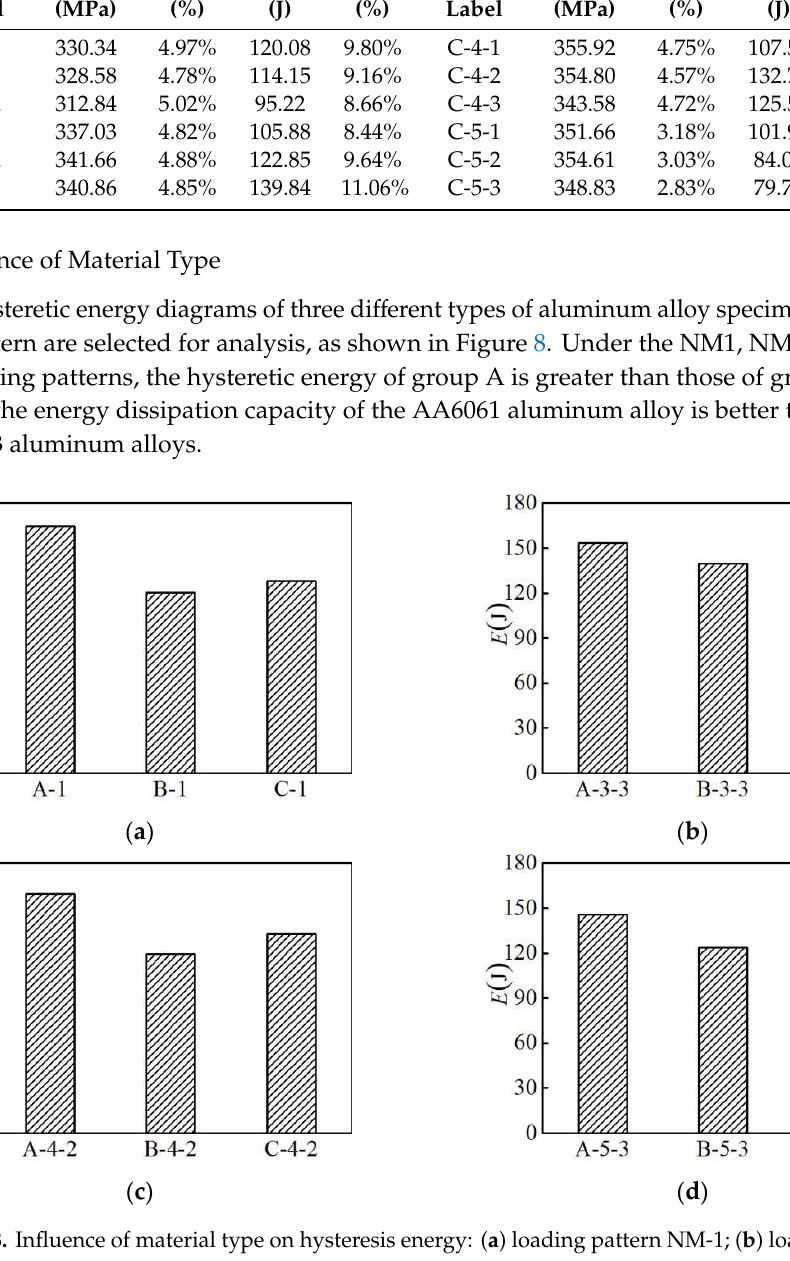
Figure 8. Influence of material type on hysteresis energy: ( a ) loading pattern NM-1; ( b ) loading pattern NM-3-3; ( c ) loading pattern NM-4-2; ( d ) loading pattern NM-5-3.